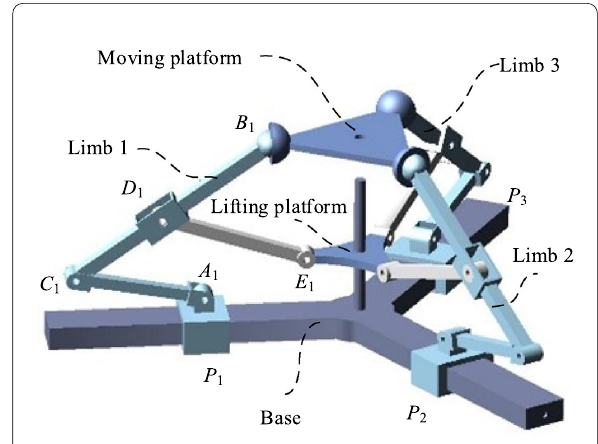
Figure 19 The initial position of the mechanism simulation